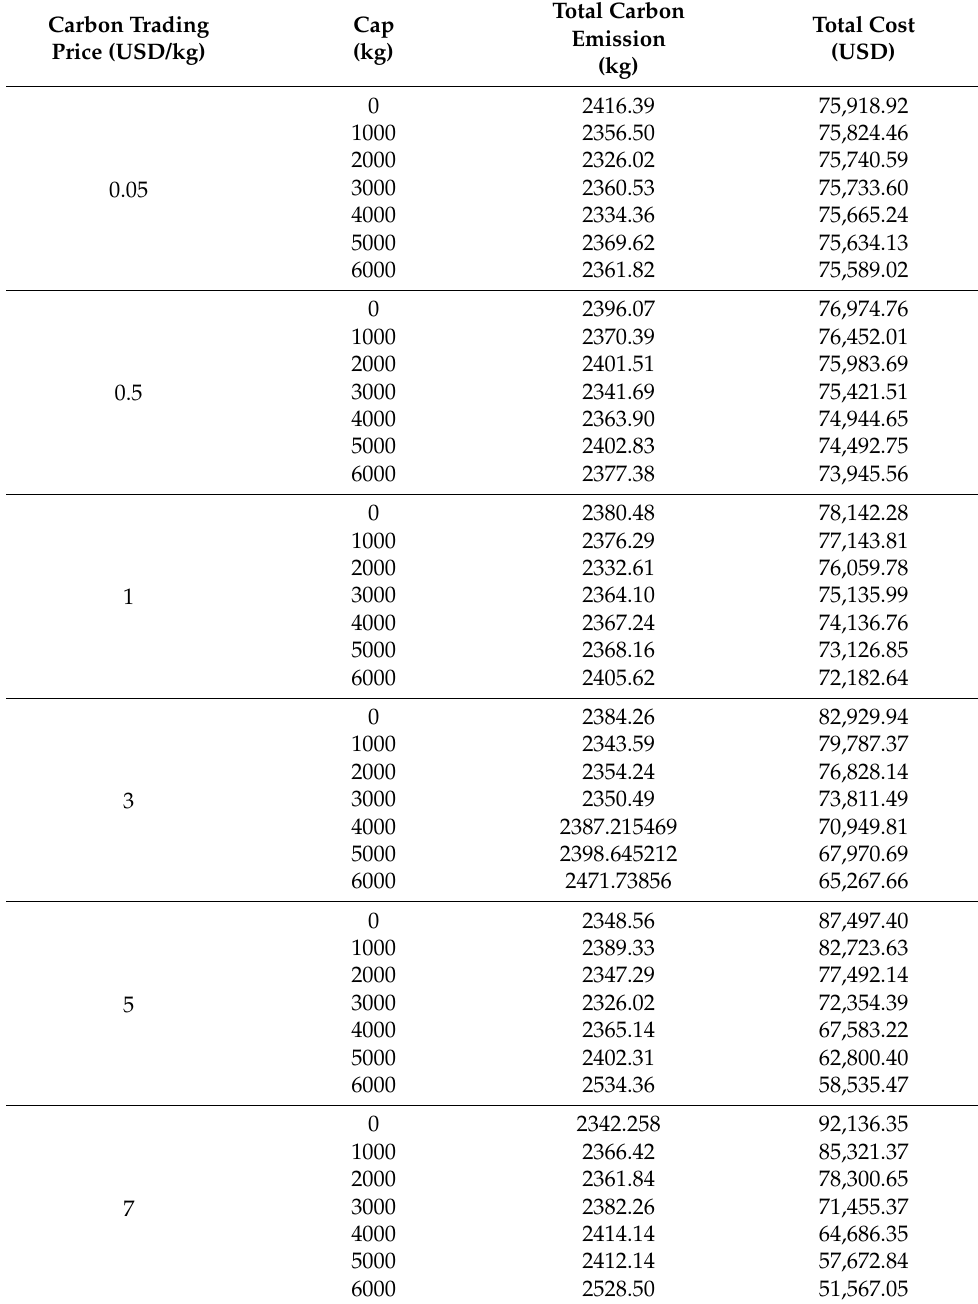
Table 12. The relationship between total cost and total carbon emission and carbon